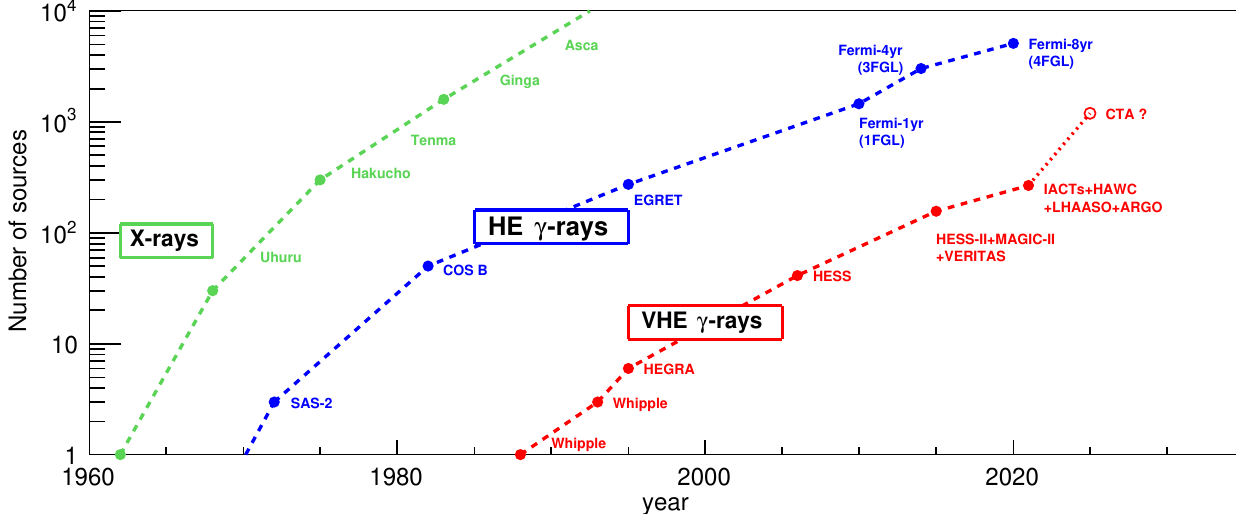
Figure 20. Number of established sources as function of time in different energy domains, also dubbed the “Kifune Plot”, in honour of Prof. Tadashi Kifune, who produced the first version of this